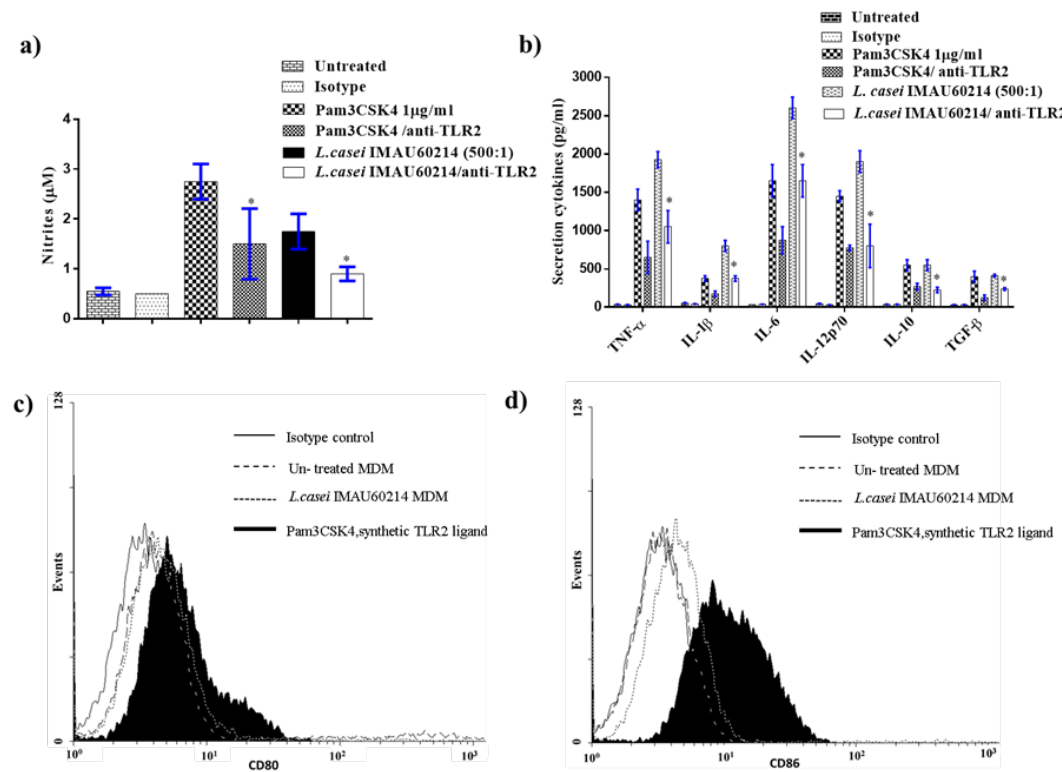
Figure 6. E ff ects of heat-killed L. casei IMAU60214 on MDMs are dependent on the activation of Toll-like receptor 2. MDMs were pre-incubated with anti-TLR2 (10 µ g / ml) for 1 h prior to stimulation by L. casei IMAU60214 (at ratio of 500:1) or Pam3CSK4 (1 µ g) as a positive control for 24 h. Control MDMs were left untreated as a negative control. ( a ) NO accumulation. ( b ) Cytokine production. * Statistically significant p < 0.05 di ff erence between conditions. ( c ) CD80 and ( d ) CD86.